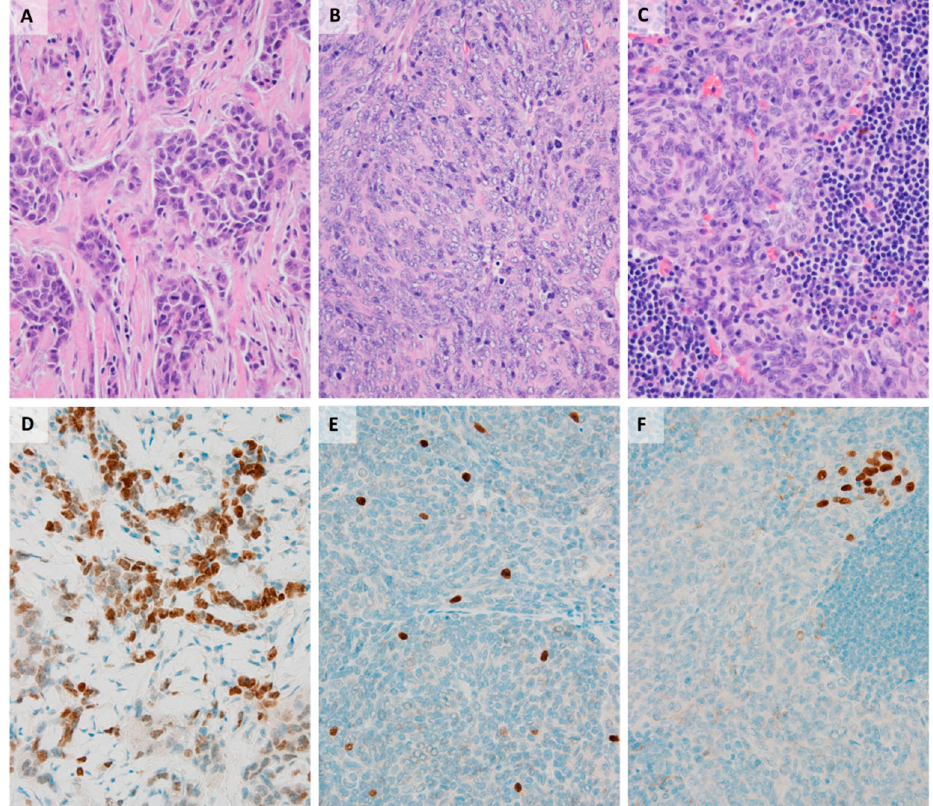
Figure 5. Hematoxylin and eosin ( A – C ) and POU2F3 ( D – F ) immunostaining in a thymic squamous cell carcinoma ( A , D ), a type A thymoma ( B , E ) and a micronodular thymoma with lymphoid stroma ( C , F ). The carcinoma shown in ( D ) was scored as staining in ≥ 10% of hotspot tumor cells, and the thymomas shown in ( E , F ) were scored as staining in <10% of hotspot tumor cells. All images are at 400 ×